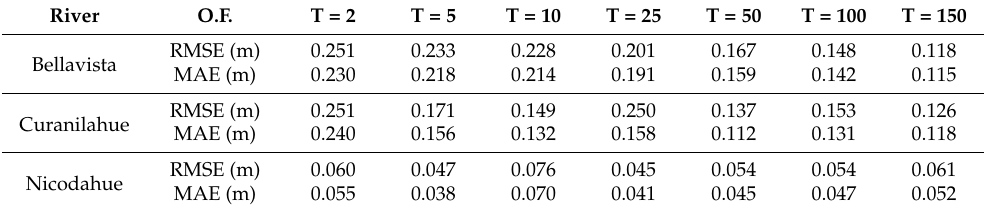
Table 3. Objective functions (O.F.), Root Mean Square Error (RMSE) and Mean Absolute Error (MAE) values for the WSE comparison at different return periods for the Bellavista, Curanilahue, and Nicodahue rivers.